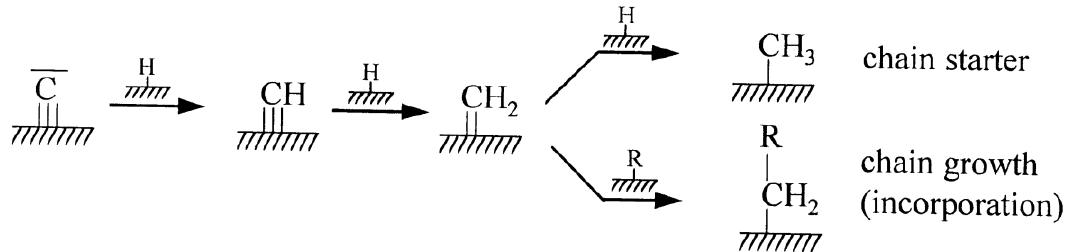
Figure 4. Simplified kinetic scheme of the successive hydrogenation of surface carbon yielding chain starters and incorporation into growing chains [88].